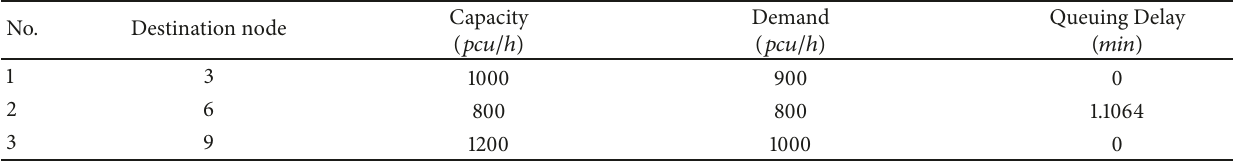
Table 7: Detail information for shelter choice.